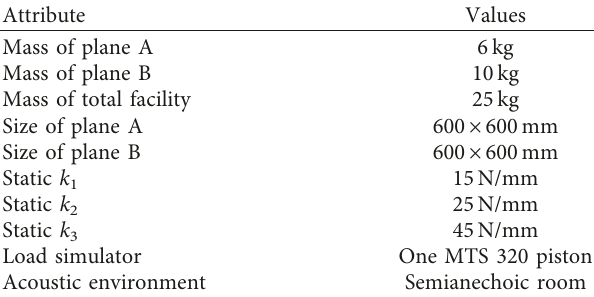
Table 2: Facility physical parameters.